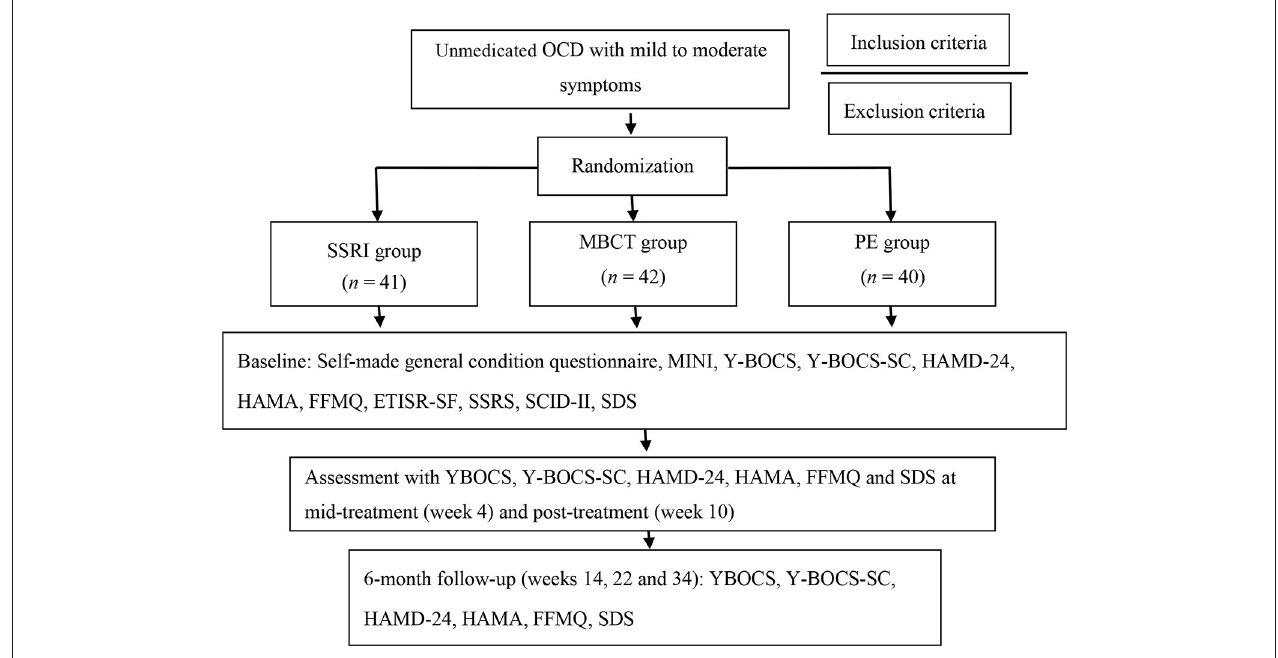
FIGURE 1 | Flow chart. MINI, Mini-International Neuropsychiatric Interview; Y-BOCS, Yale–Brown Obsessive Compulsive Scale; Y-BOCS-SC, Yale–Brown Obsessive-Compulsive Scale Symptom Checklist; HAMD-24, Hamilton Depression Scale-24; HAMA, Hamilton Anxiety Scale; FFMQ, Five Facets of Mindfulness Questionnaire; ETISR-SF, Early Trauma Inventory Self Report, Short Form; SSRS, Social Support Rating Scale; SCID-II, Structured Clinical Interview for DSM-IV Axis II disorders; SDS, Sheehan Disability Scale.